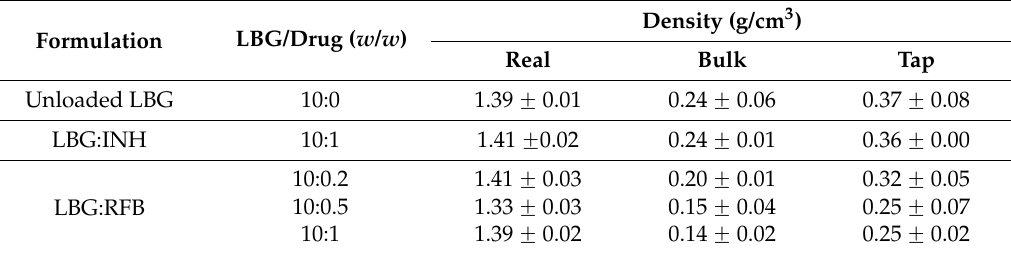
Table 2. Microparticle real, bulk and tap densities (mean ˘ SD, n = 3).